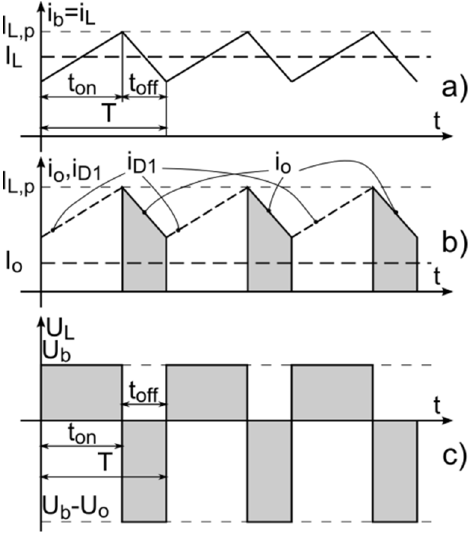
Figure 3. Layout 1 discharge operation: current and voltage waveforms (continuous